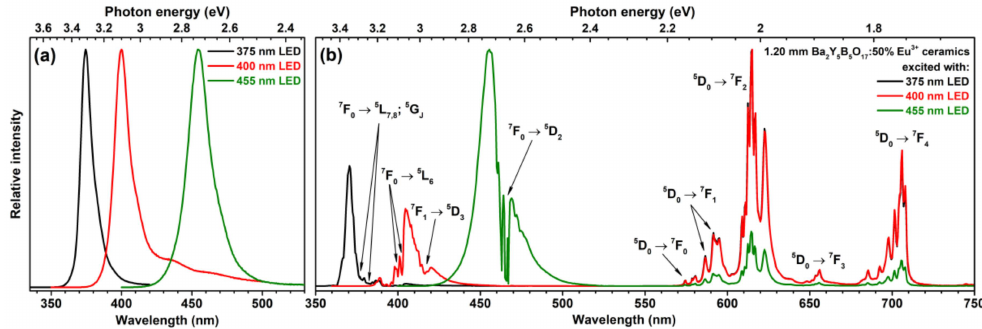
Figure 7. Emission spectra of 375, 400, and 455 nm emitting LEDs ( a ). Emission spectra of 1.20-mm-thick Ba 2 Y 5 B 5 O 17 :50%Eu 3 + ceramic disk excited with 375, 400, and 455 nm emitting LEDs ( b